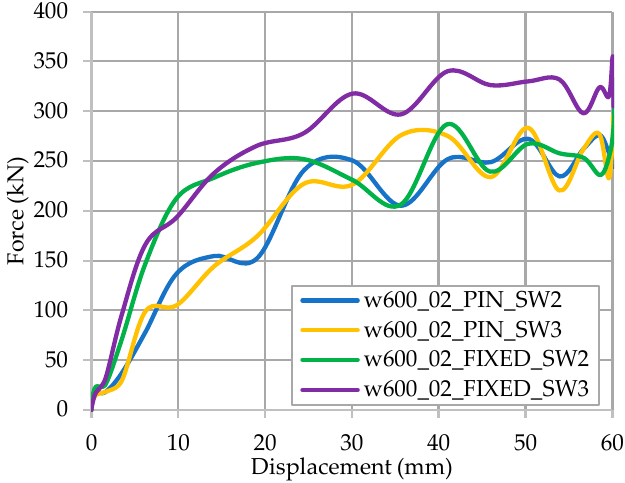
Figure 26. Force/displacement diagrams for 2 SW and 3 SW configurations of the pinned and fixed beam with shear connectors spaced at 600 mm.